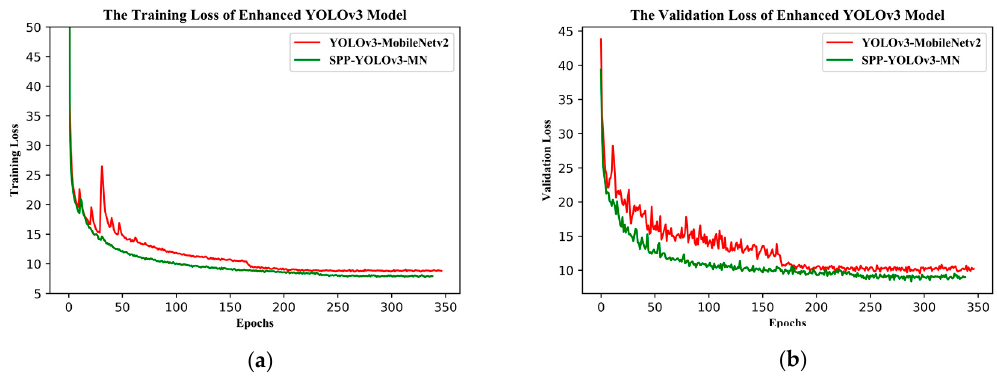
Figure 12. ( a ) Training and ( b ) validation losses of the enhanced YOLOv3 Figure 12. (a) Training and (b) validation losses of the enhanced YOLOv3 model.